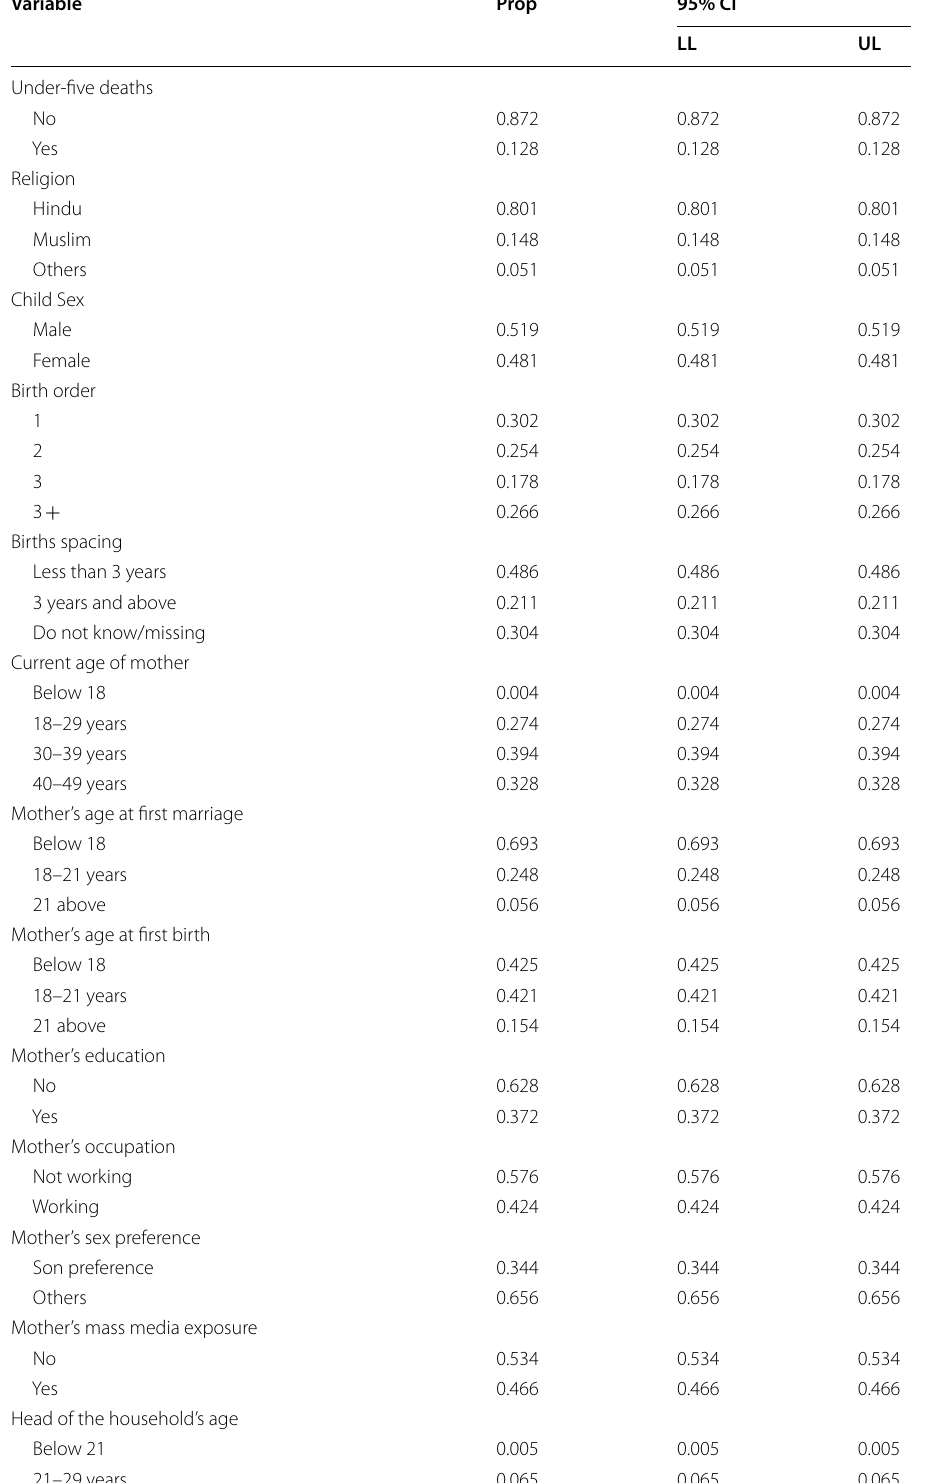
Table 2 Sample distribution of study population (N characteristics, 1992 to